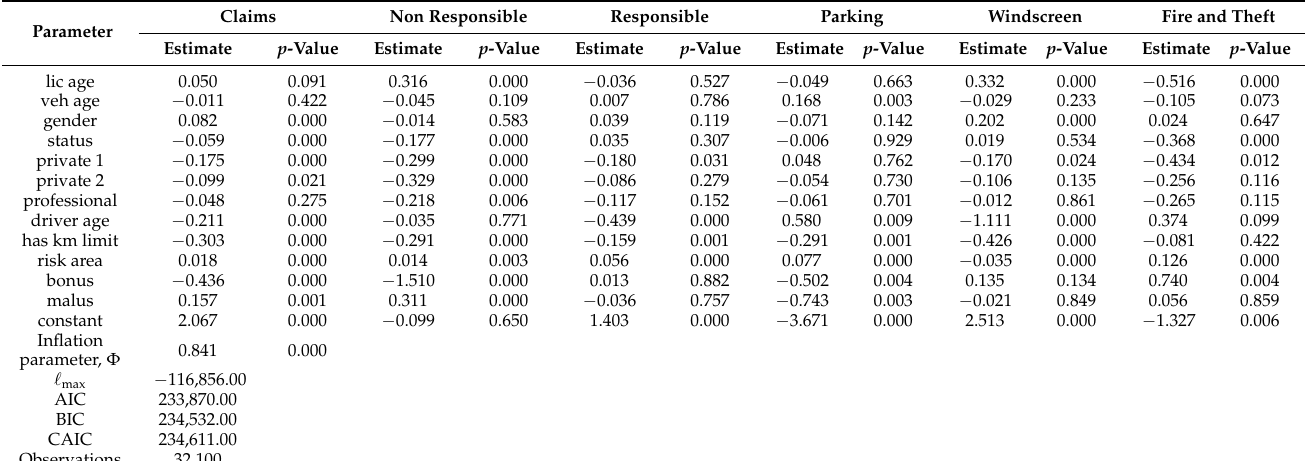
Table 7. Parameter estimates and p -values for the zero-inflated regression model. Some measures of the model selection are also exhibited.